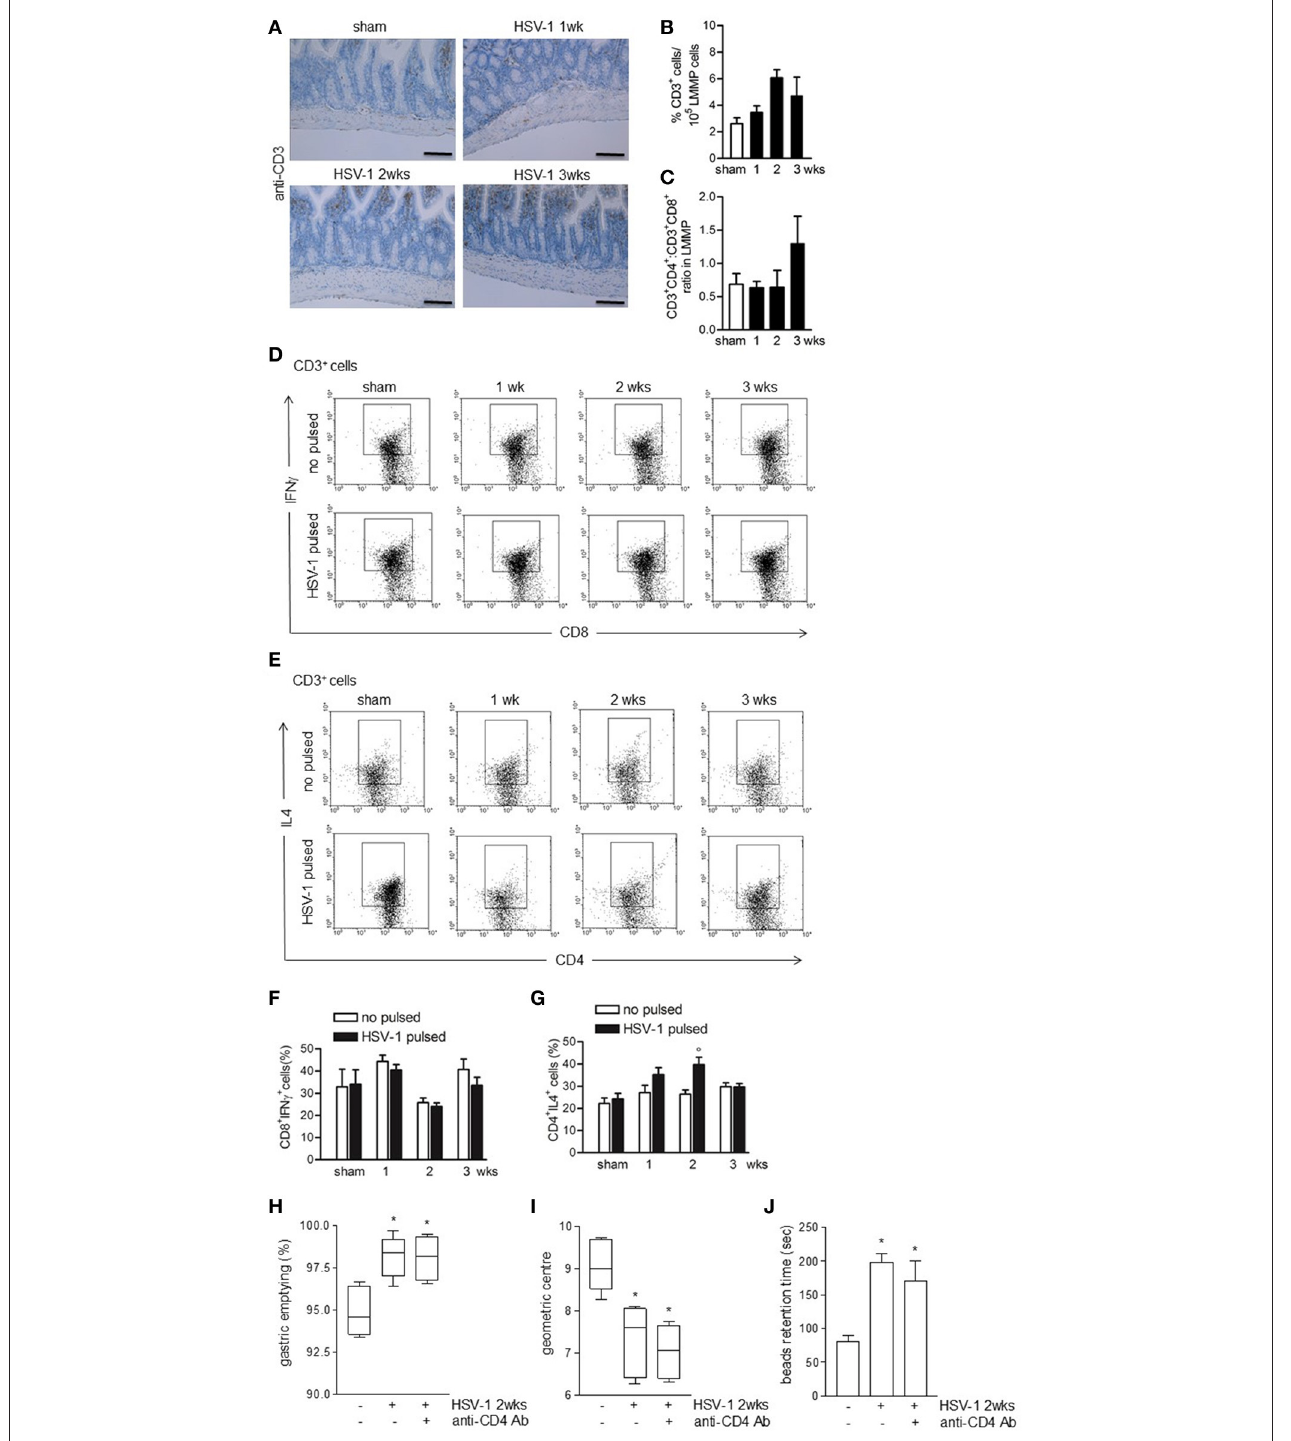
FIGURE 5 | Weak adaptive immune response in the LMMP following HSV-1 administration. (A) Sections of ileum obtained from sham or HSV-1 strain SC16 infected mice were subjected to immunohistochemistry for CD3. Scale bars: 40 µ m. Representative images of three separate experiments. (B) Freshly collected LMMP were digested and the resulting cell suspension were labeled with anti-CD3 antibody and analyzed by flow cytometry. CD3 + cells were expressed as percentage of 10 5 collected events. (C) Cell suspensions obtained from LMMP as previously described were labeled with anti-CD3, anti-CD4 or anti-CD8 antibodies and analyzed by flow cytometry. CD4:CD8 ratio of 1 × 10 5 CD3 + cells was calculated. (D,E) Cell suspensions obtained from LMMP were incubated for 16h in presence or absence